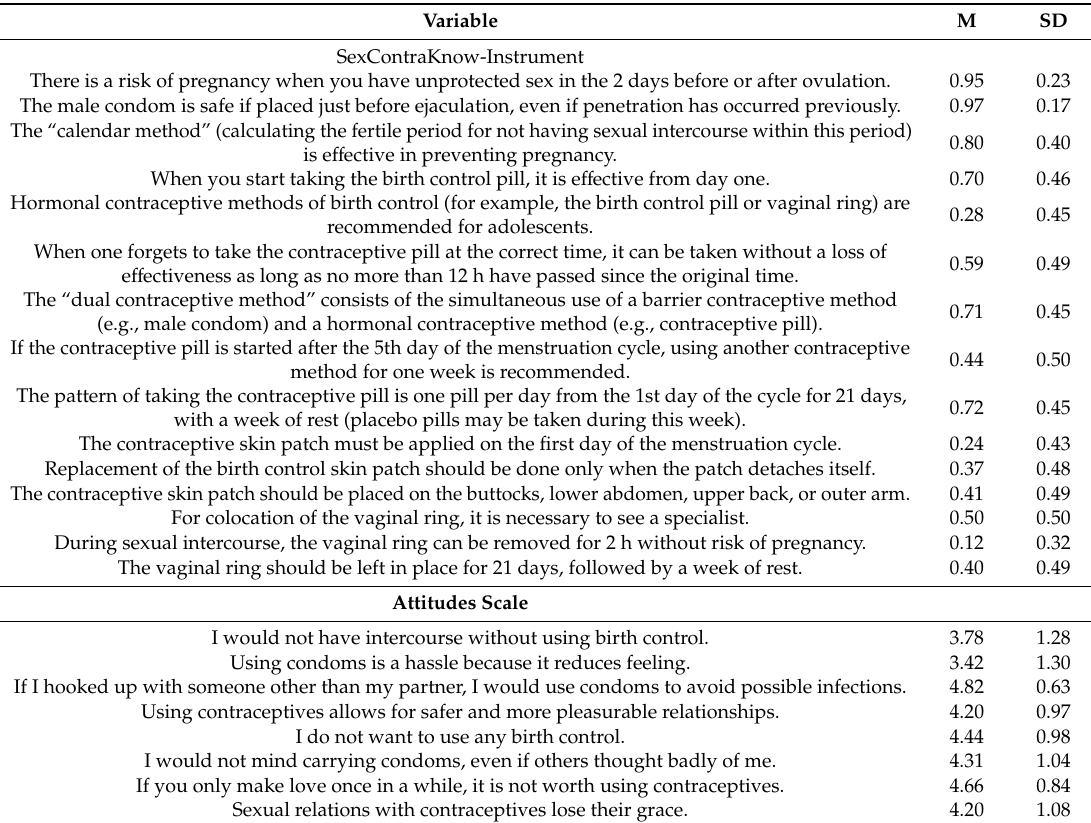
Table 2. Descriptive statistics for scales of knowledge and attitudes ( n =